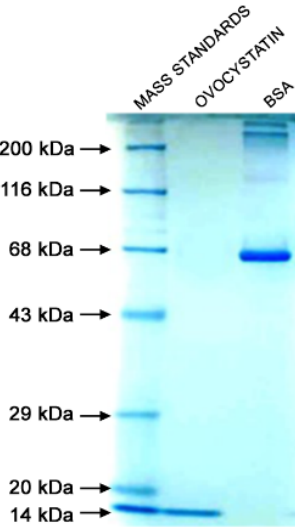
Figure 1. PAGE-SDS electrophoresis of preparation of ovocystatin in 10% gel (reducing conditions). The lanes were loaded according to the order (from left): 10 µL of the mass standards (Protein Marker III), 10 µL of 0.2 mg/mL ovocystatin, 10 µL of 0.2 mg/mL BSA, and separation was carried out in 25 mM TRIS/192 mM glycine buffer pH 8.3 with 0.1% SDS for 90 min. The bovine serum albumin was loaded as an additional control.